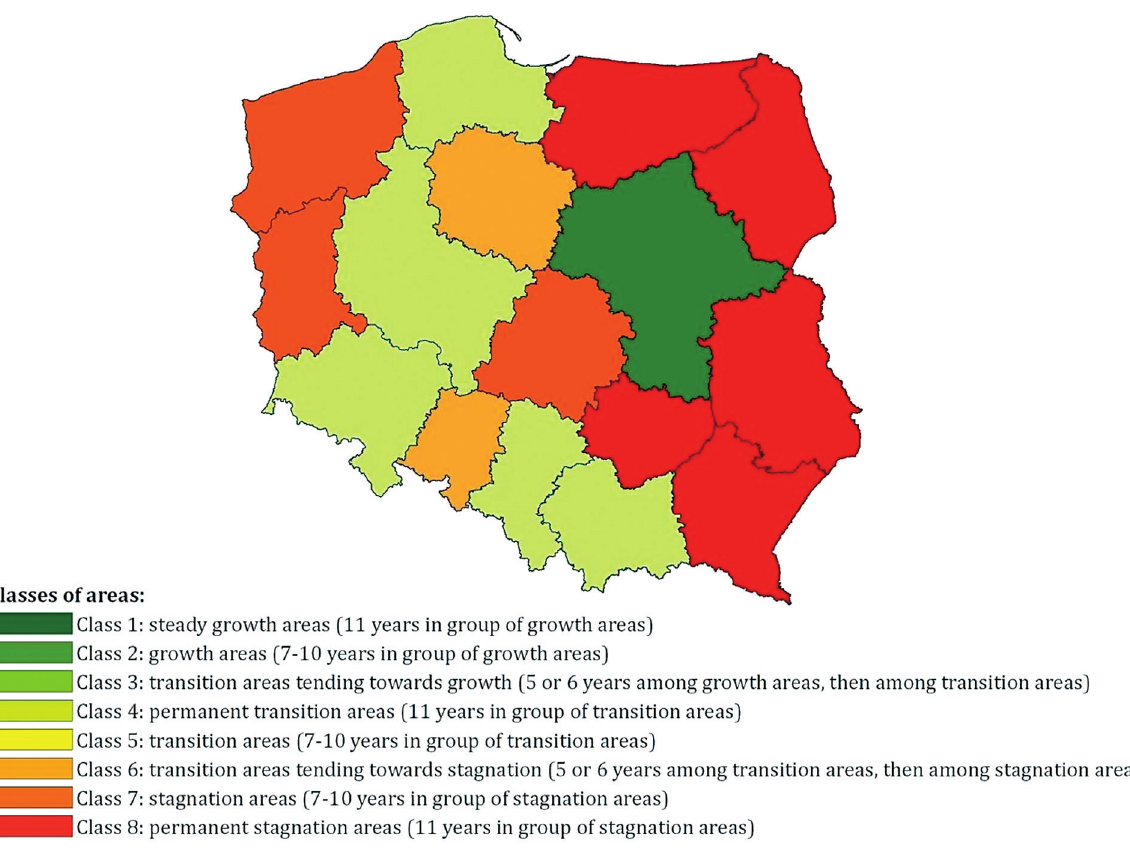
Fig. 3. Spatial distribution of classes of growth and stagnation areas by NUTS 2 units: a general approach Source: own